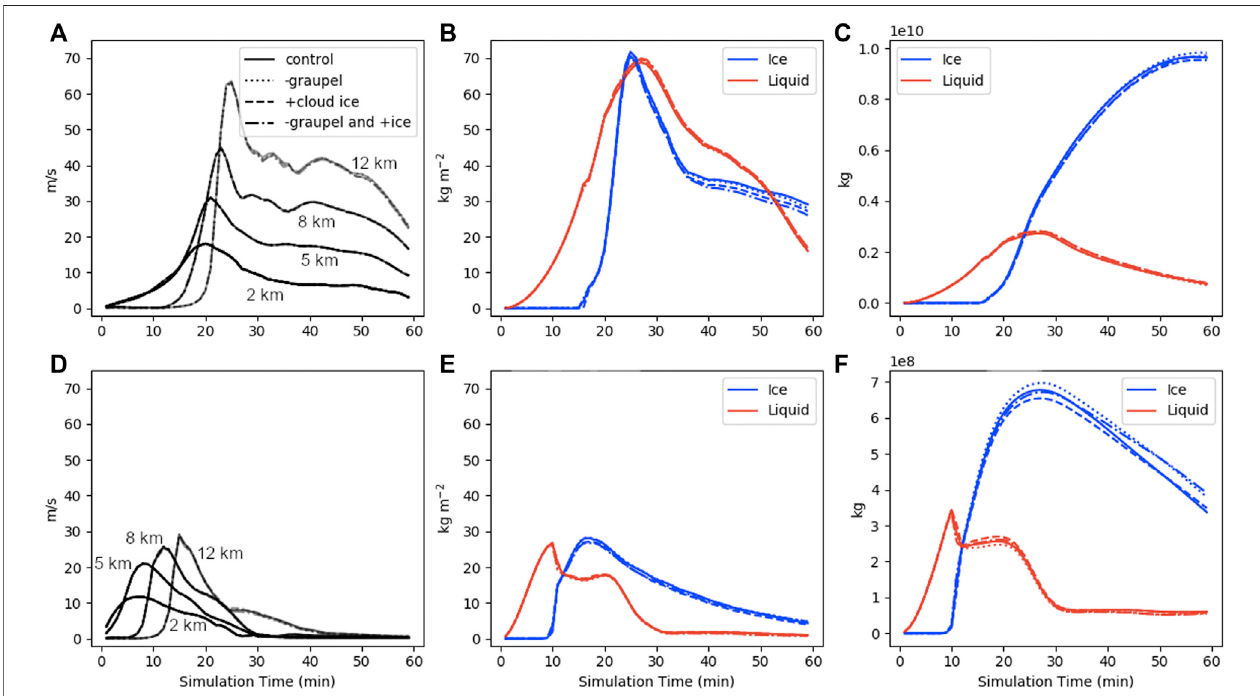
FIGURE2| Timeseries ofthemaximum updraftspeedat fouraltitudes [inm/s,subplots (A,C) ],maximumiceand liquidwaterpaths (inkg/m 2 ,subplots (B,E) ,and total ice and liquid condensate mass [in kg, subplots (C,F) ] for the strong (top) and weak (bottom) convection cell simulations and for the four microphysical situations.